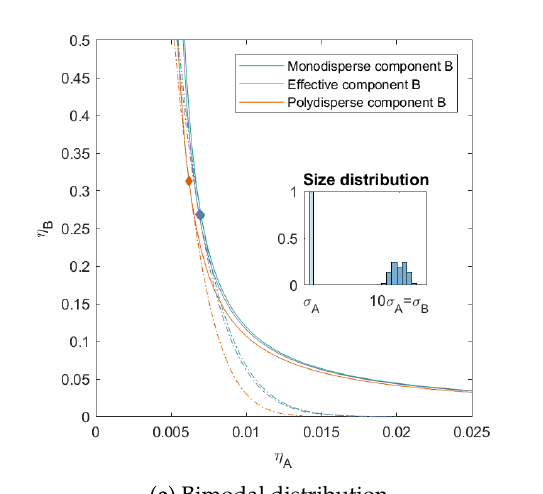
Figure 6. Phase diagram for binary (component A and B ) additive hard sphere mixture with size ratio q = σ A / σ B = 1/10, component A is monodisperse, component B is polydisperse (see size distributions for the different distribution), with a number average size 10 times the size of component A , plotted as a function of the partial packing fractions, η A and η B . The spinodal ( solid line ) and binodal ( dashed line ) meet each other at the critical point